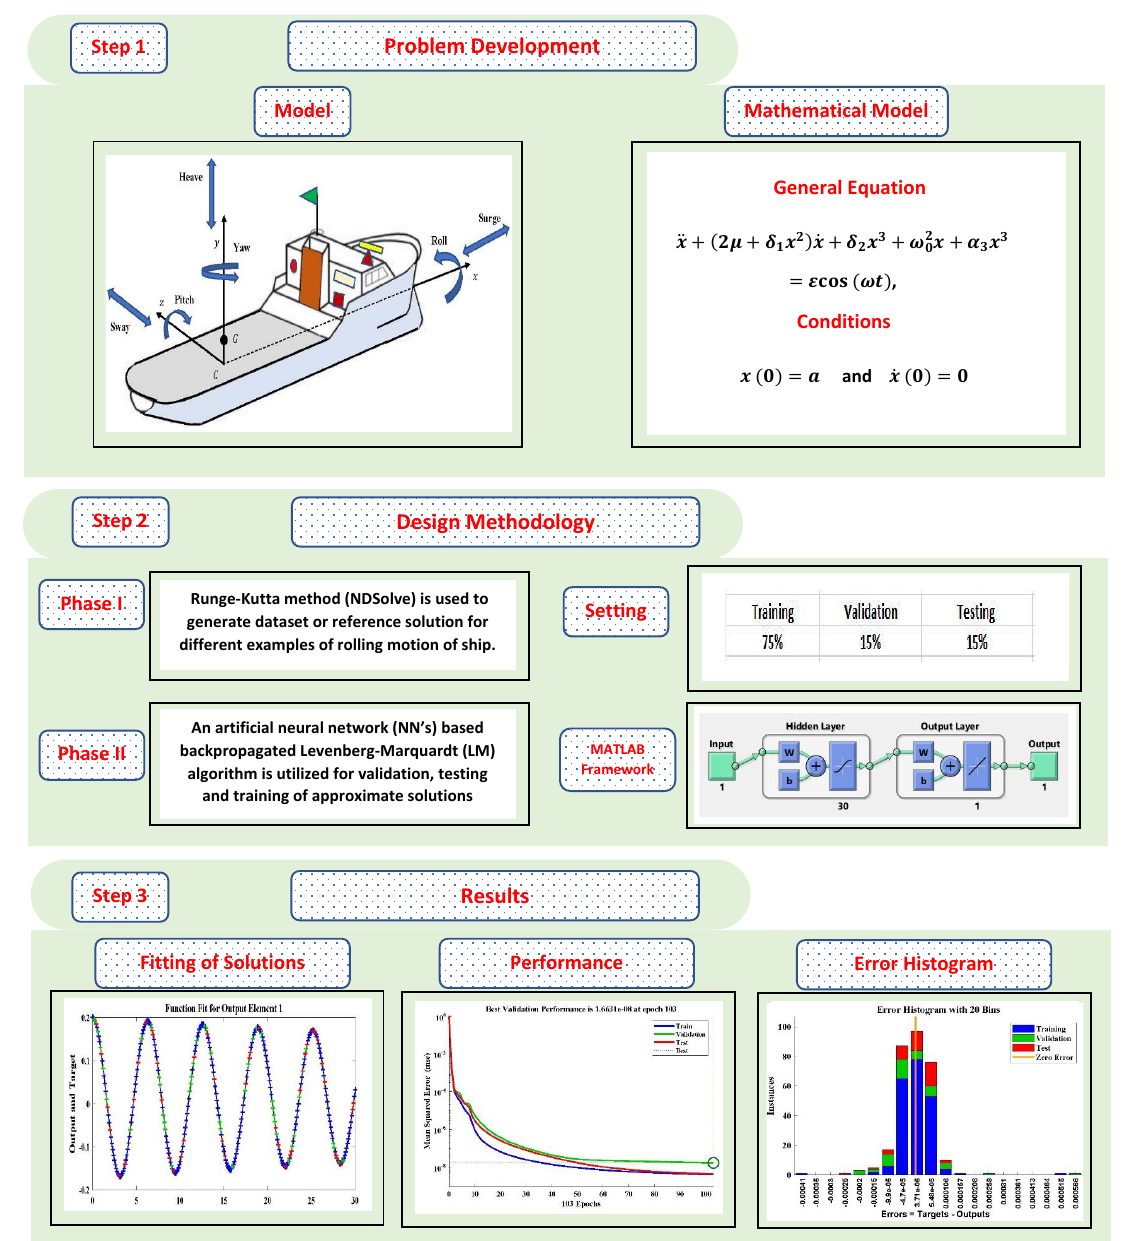
Figure 3. Architecture of the proposed methodology of the mathematical model for the rolling motion of ships in random beam seas.